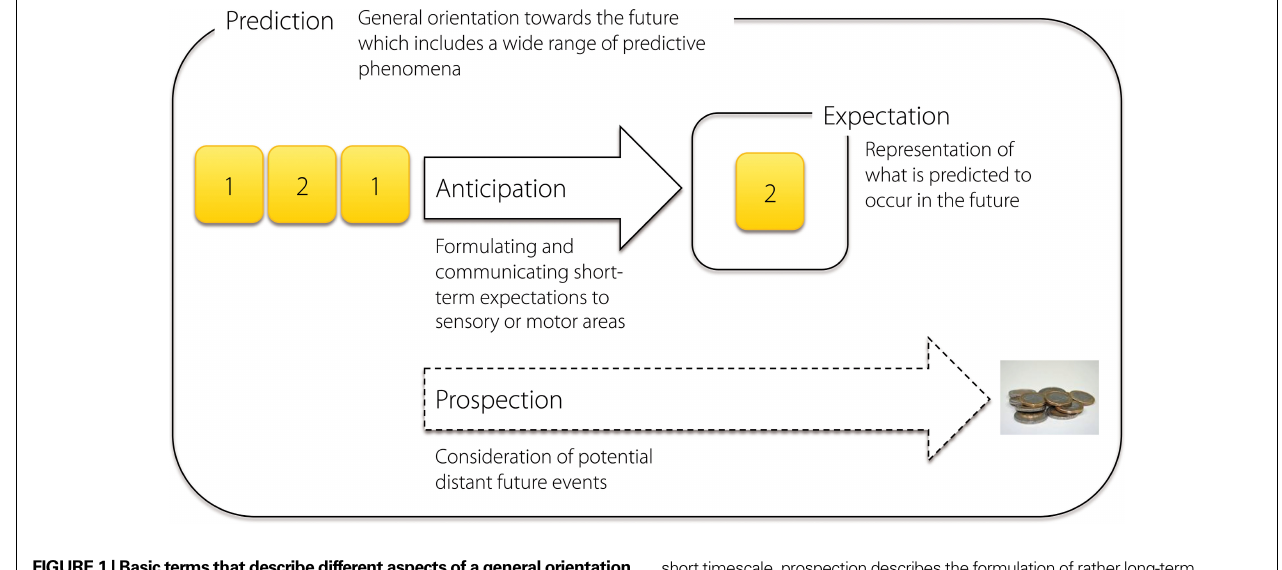
short timescale, prospection describes the formulation of rather long-term expectations which do not necessarily lead to specifi c sensory or motor pre- activations, e.g., when a participant in an experiment foresees to receive a payment after the experimental session. Although all these terms describe somewhat different phenomena, they may all be considered as specifi c aspects of a common directedness towards the future which may be termed